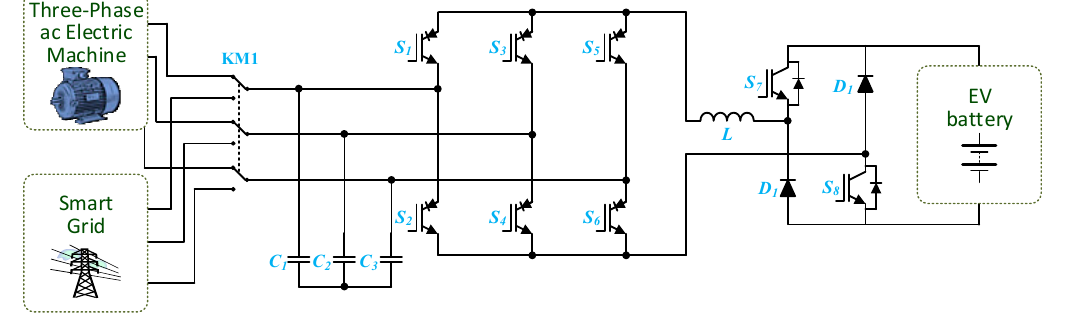
Figure 27. Unified power converter topology based on current source converter.